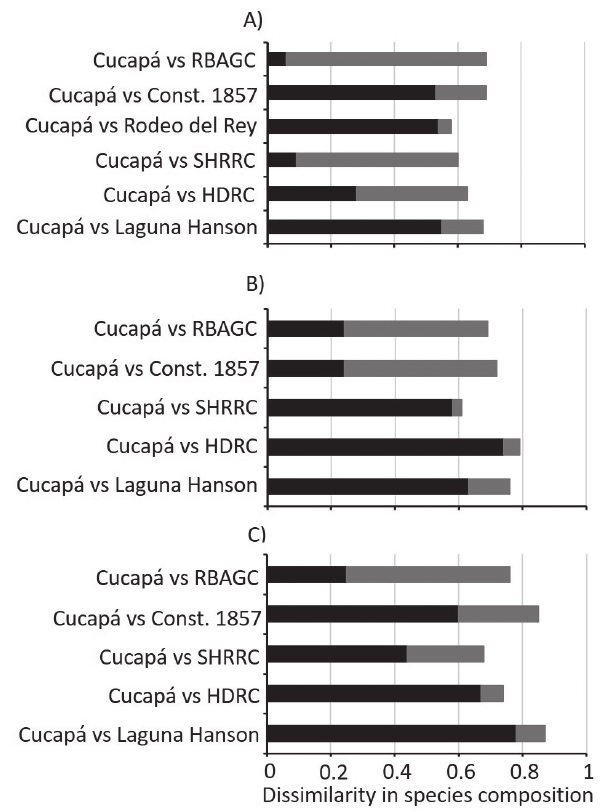
Figure 2. Differences in species composition between Cucapá and the NPAs A birds B mammals C reptiles. Total difference in species composition ( β ; complete bar), proportion of the difference due to jac species turnover ( β ; black portion of bar) and proportion of the difference due to nestedness ( β jtu portion of